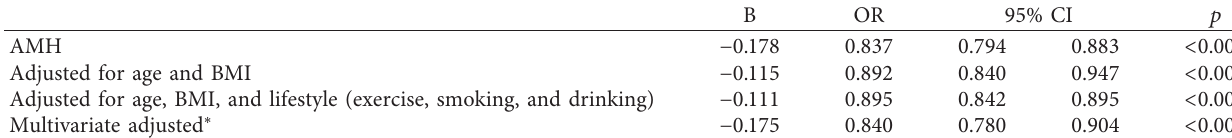
Table 2: Binary logistic regression with HOMA-IR as the output variable in PCOS patients.